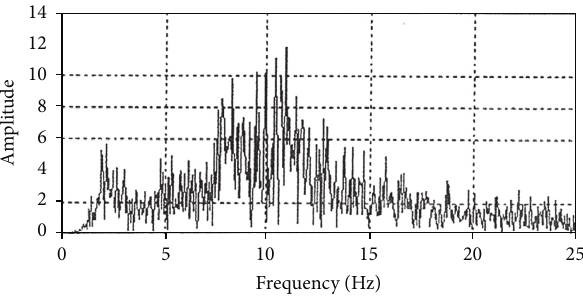
Figure 5: Filtered frequency content.